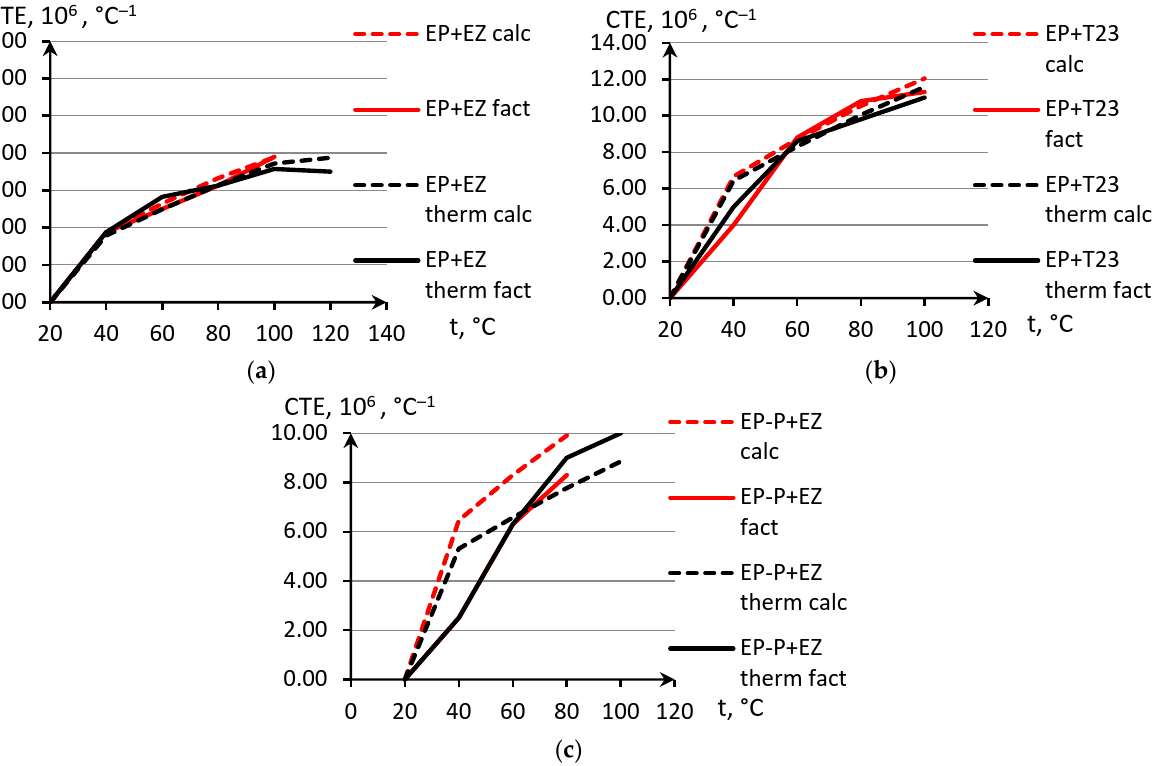
Figure 12. Experimental and model GRPs’ CNTE curves in temperature range of non-linear section. ( a ) EP+EZ, ( b ) EP+T23, ( c )